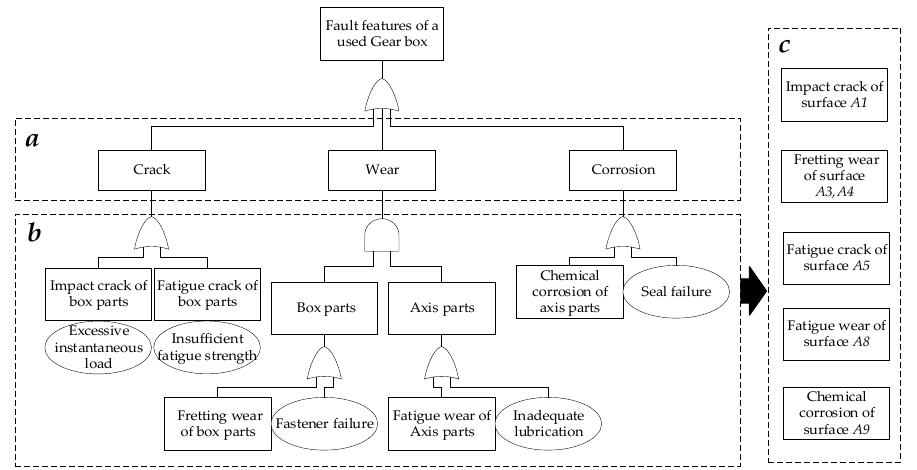
Figure 7. Failure feature type of a used gearbox identified by FTA. The volume damage of the failure surface is obtained with a CAD model. Then, the failure quantification is obtained according to the corresponding criteria in Table 1. Once the failure type and quantification of failure surface is obtained, the failure characteristics set, and attribute feature set of each failure surface, is shown in Table 2. Table 2. Characteristics set of each failure surface of a used gearbox for CBR. Surface No.